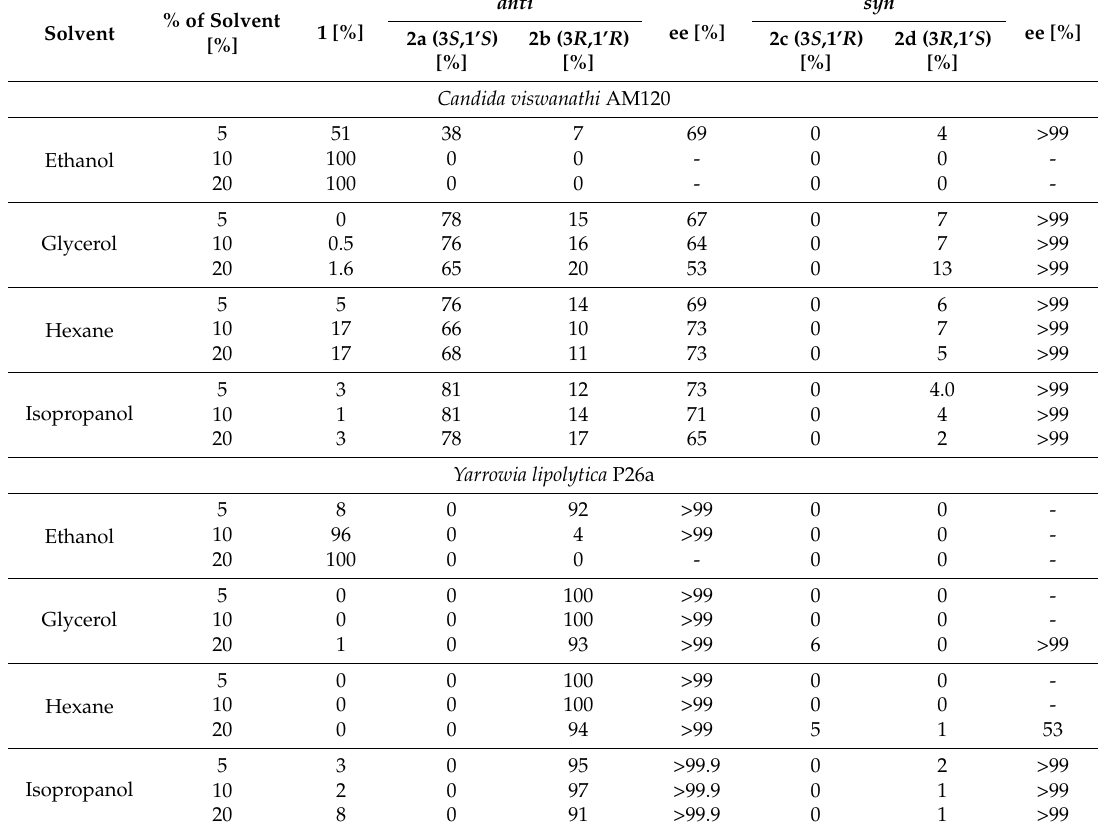
Table 5. The biotransformation of α -acetylbutyrolactone 1 by Candida viswanathi AM120 and Yarrowia lipolytica P26A in mixtures of medium with different solvents in different proportions after 1 day (in % according to